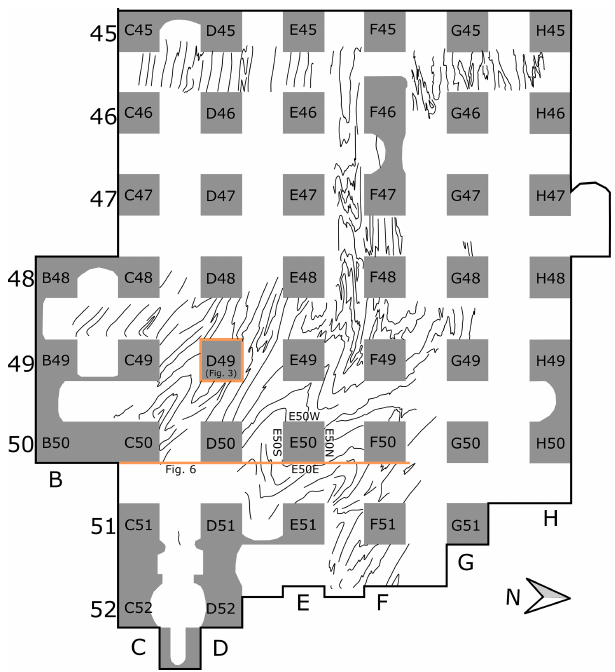
Figure 2. Map of the studied area in the + 226 horizon of the Ocnele Mari salt mine, illustrating the position of the pillars. Curves be- tween the pillars show traces of the layers observed on the mine ceil- ing. The thick orange line along the eastern sides of line 50 marks the position of the cross section through the mine (see Fig. 6). The orange square indicates the pillar presented in Fig. 3. The public area of the mine (shown on the map) is approximately 180m by 210m and has a height of approximately